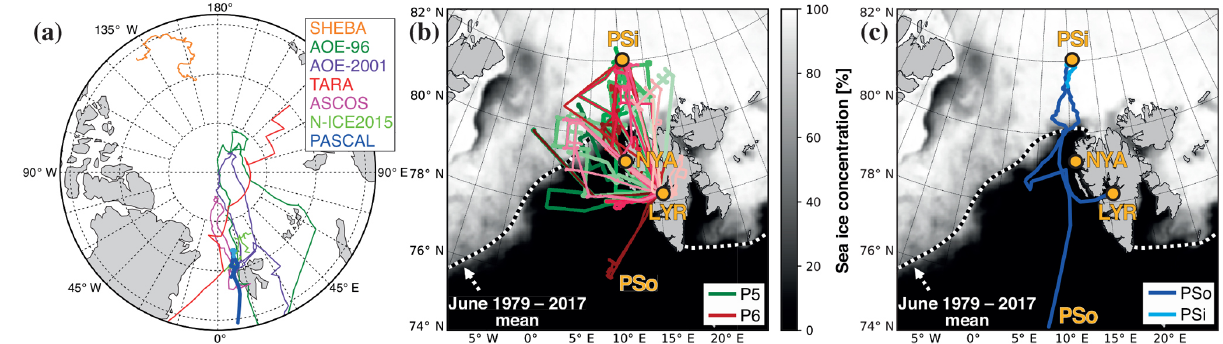
Figure 1. Overview of the (a) Arctic and (b, c) ACLOUD/PASCAL region. (a) Tracks of the icebreaker Polarstern during PASCAL (blue) and previous Arctic ship-based campaigns (orange to light green; see Sect. 5.4 for description). For the former, dark and bright colors indi- cate ocean-cruising (PSo; 30 May–5 June and 17–18 June 2017) and ice-attached (PSi; 6–16 June 2017) positions, respectively. (b) Tracks of the aircraft Polar 5 (green) and Polar 6 (red) flights during ACLOUD (23 May–26 June 2017), with later dates in brighter colors. (c) Track of PSo cruise and PSi position (blue). In panels (b) and (c) , codes represent Longyearbyen (LYR), Ny-Ålesund (NYA), PSo entering the ACLOUD/PASCAL region, and PSi, while the shading and the dashed line represent the average sea ice concentration over the ACLOUD/PASCAL measurement period (23 May–26 June 2017) and edge (defined by 15% concentration) (June 1979–2017), respectively (see Sect. 2.3 for data